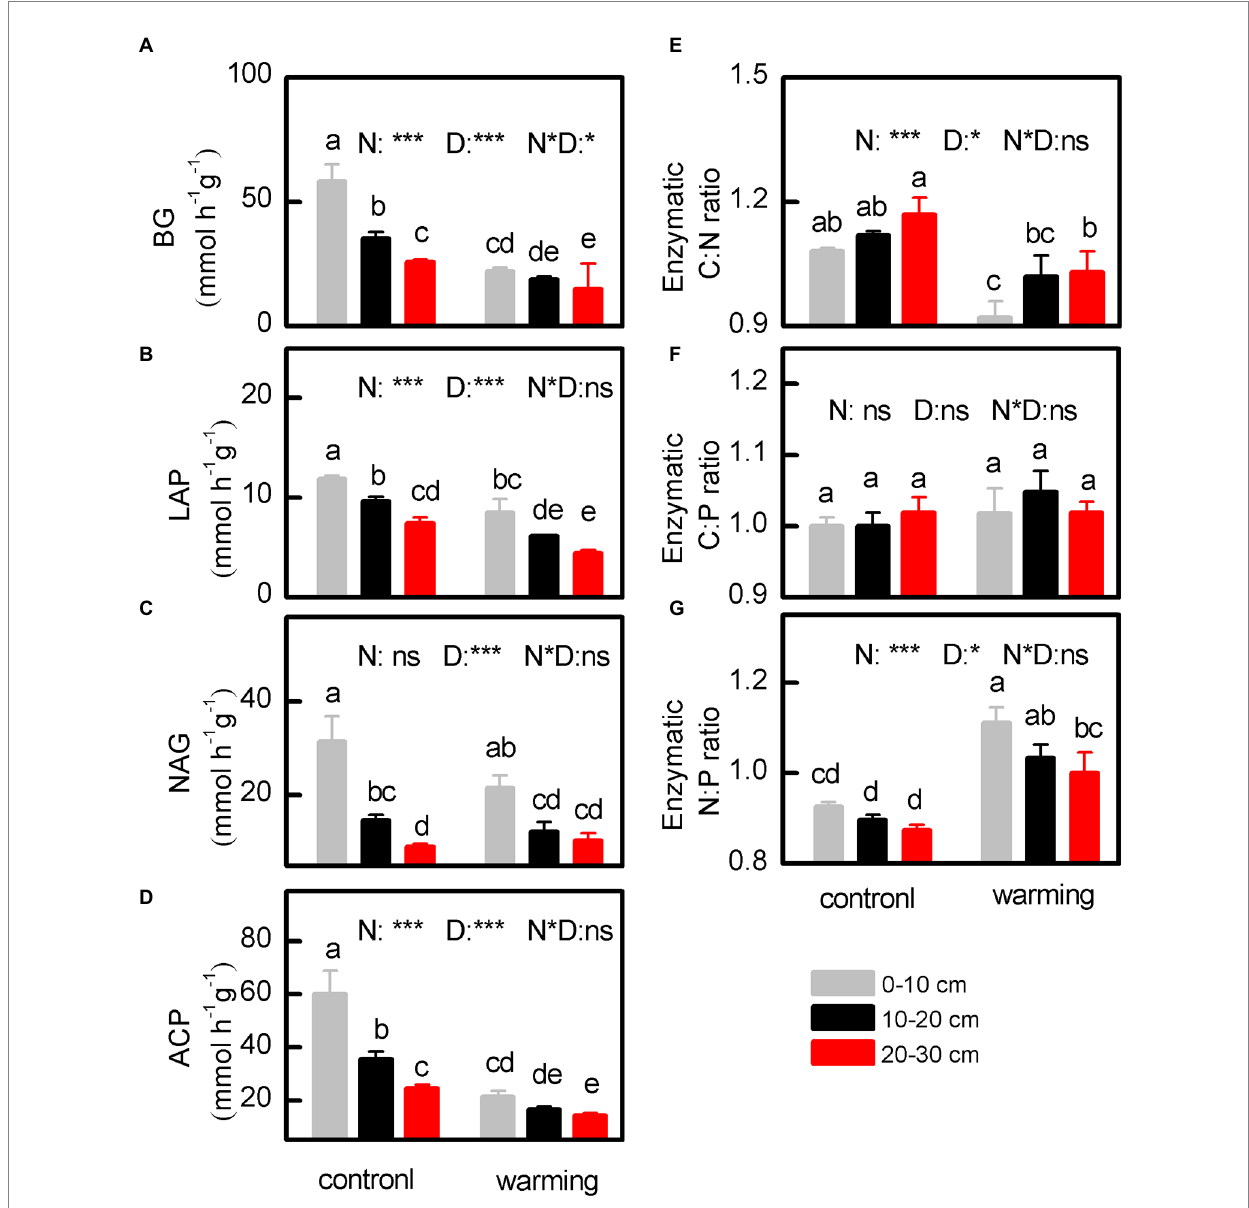
FIGURE 5 The activity of BG ( β -1,4-glucosidase) (A) , LAP (leucine aminopeptidase) (B) , NAG ( β -1,4-N-acetylglucoaminosidase) (C) and ACP (acid phosphatase) (D) and the stoichiometric ratios of C-, N- and P-degrading enzymes (E–G) of soil under control and warming. p -value of the ANOVA of treatments (control and warming, N), soil depths (0–10, 10–20 and 20–30 cm, D) and interactive of treatments and soil depths (N*D) is indicated: * p ≤ 0.05; ** p ≤ 0.01; *** P ≤ 0.001; ns, not